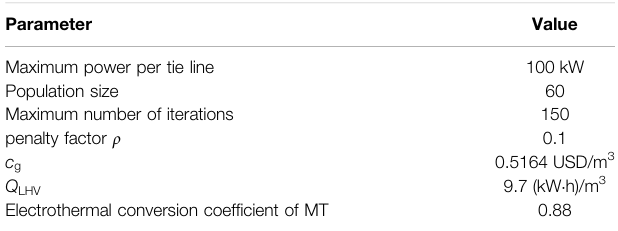
FIGURE 5 | Proposed system con fi guration. TABLE 1 | Status parameters.